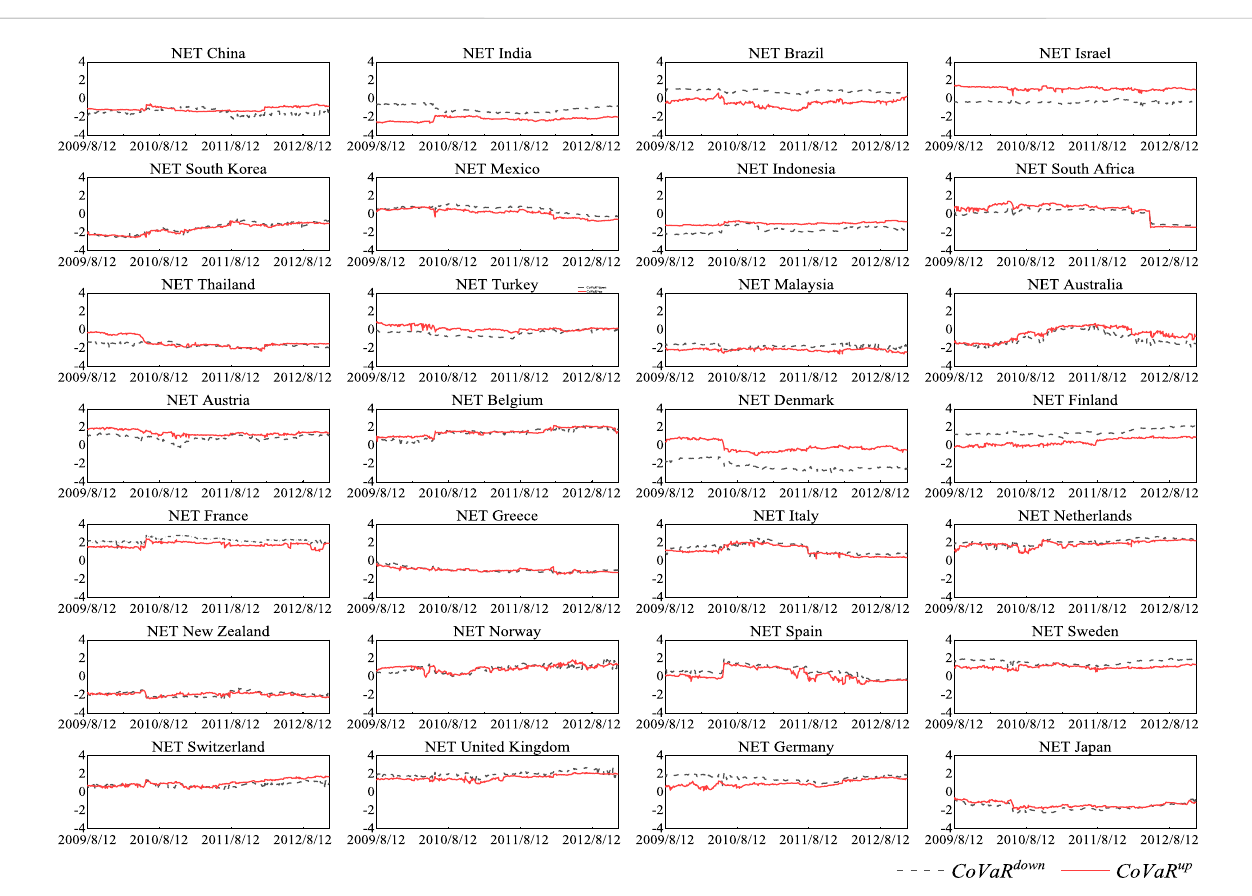
FIGURE 4 Net spillovers (1st commitment period). Note: The unit of the vertical axis is